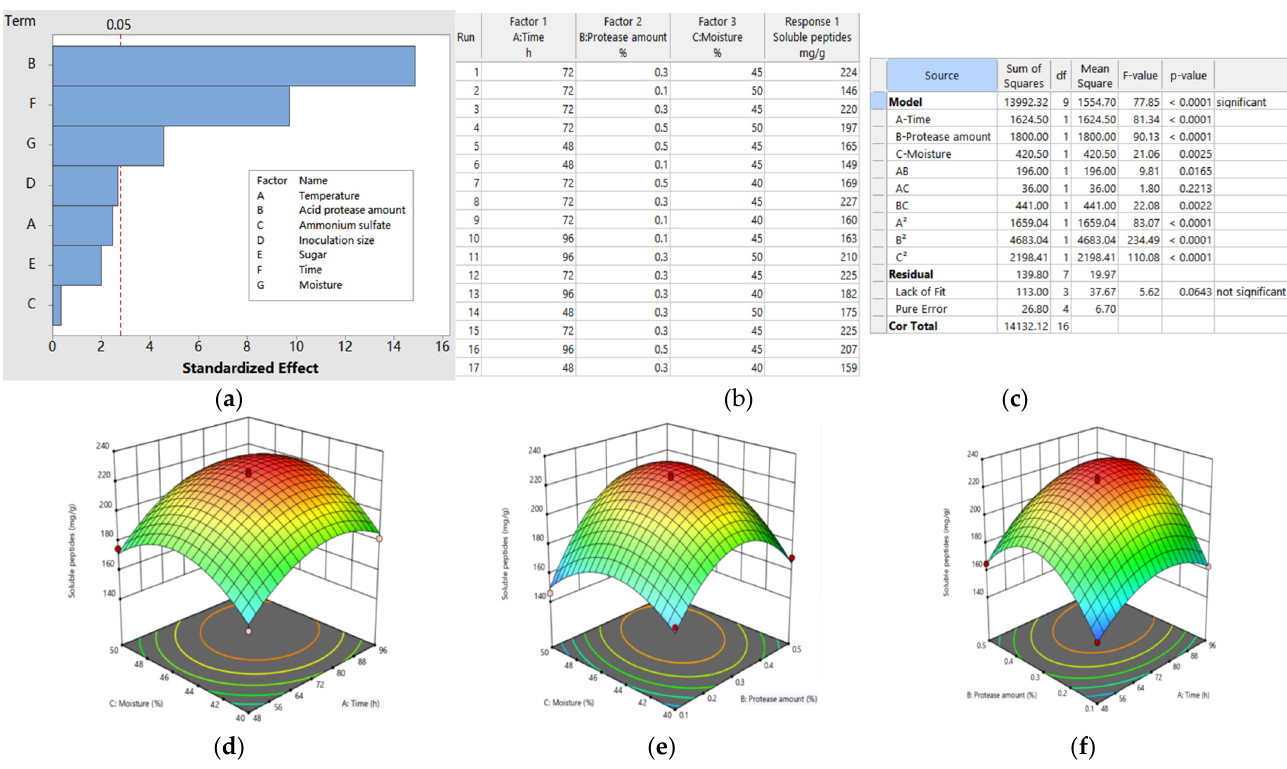
Figure 4. Optimization of fermentation conditions and response surface plots showing the interaction effect of variables on soluble peptide yield. ( a ) Pareto diagram describing the impact of factors (temperature, acid protease amount, ammonium sulfate, inoculation size, sugar, time and moisture) evaluated by a Plackett–Burman design on soluble peptide yield (mg/g); ( b ) Box Behnken design matrix for optimization of soluble peptide yield (mg/g); ( c ) analysis of variance (ANOVA) for response surface quadratic model on soluble peptide yield (mg/g); ( d ) interaction of moisture (%) and time©); ( e ) interaction of moisture (%) and acid protease amount (%); ( f ) interaction of acid protease amount (%) and time (h).